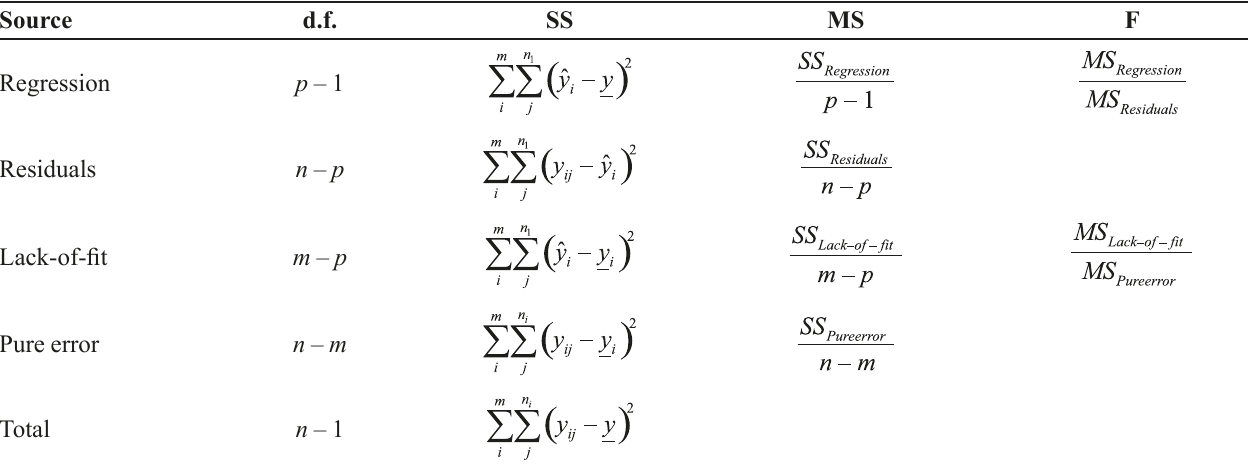
TABLE VI – Analysis of variance (ANOVA) used in multiple regression analysis to evaluate regression significance, residual error, and lack-of-fit adjustment